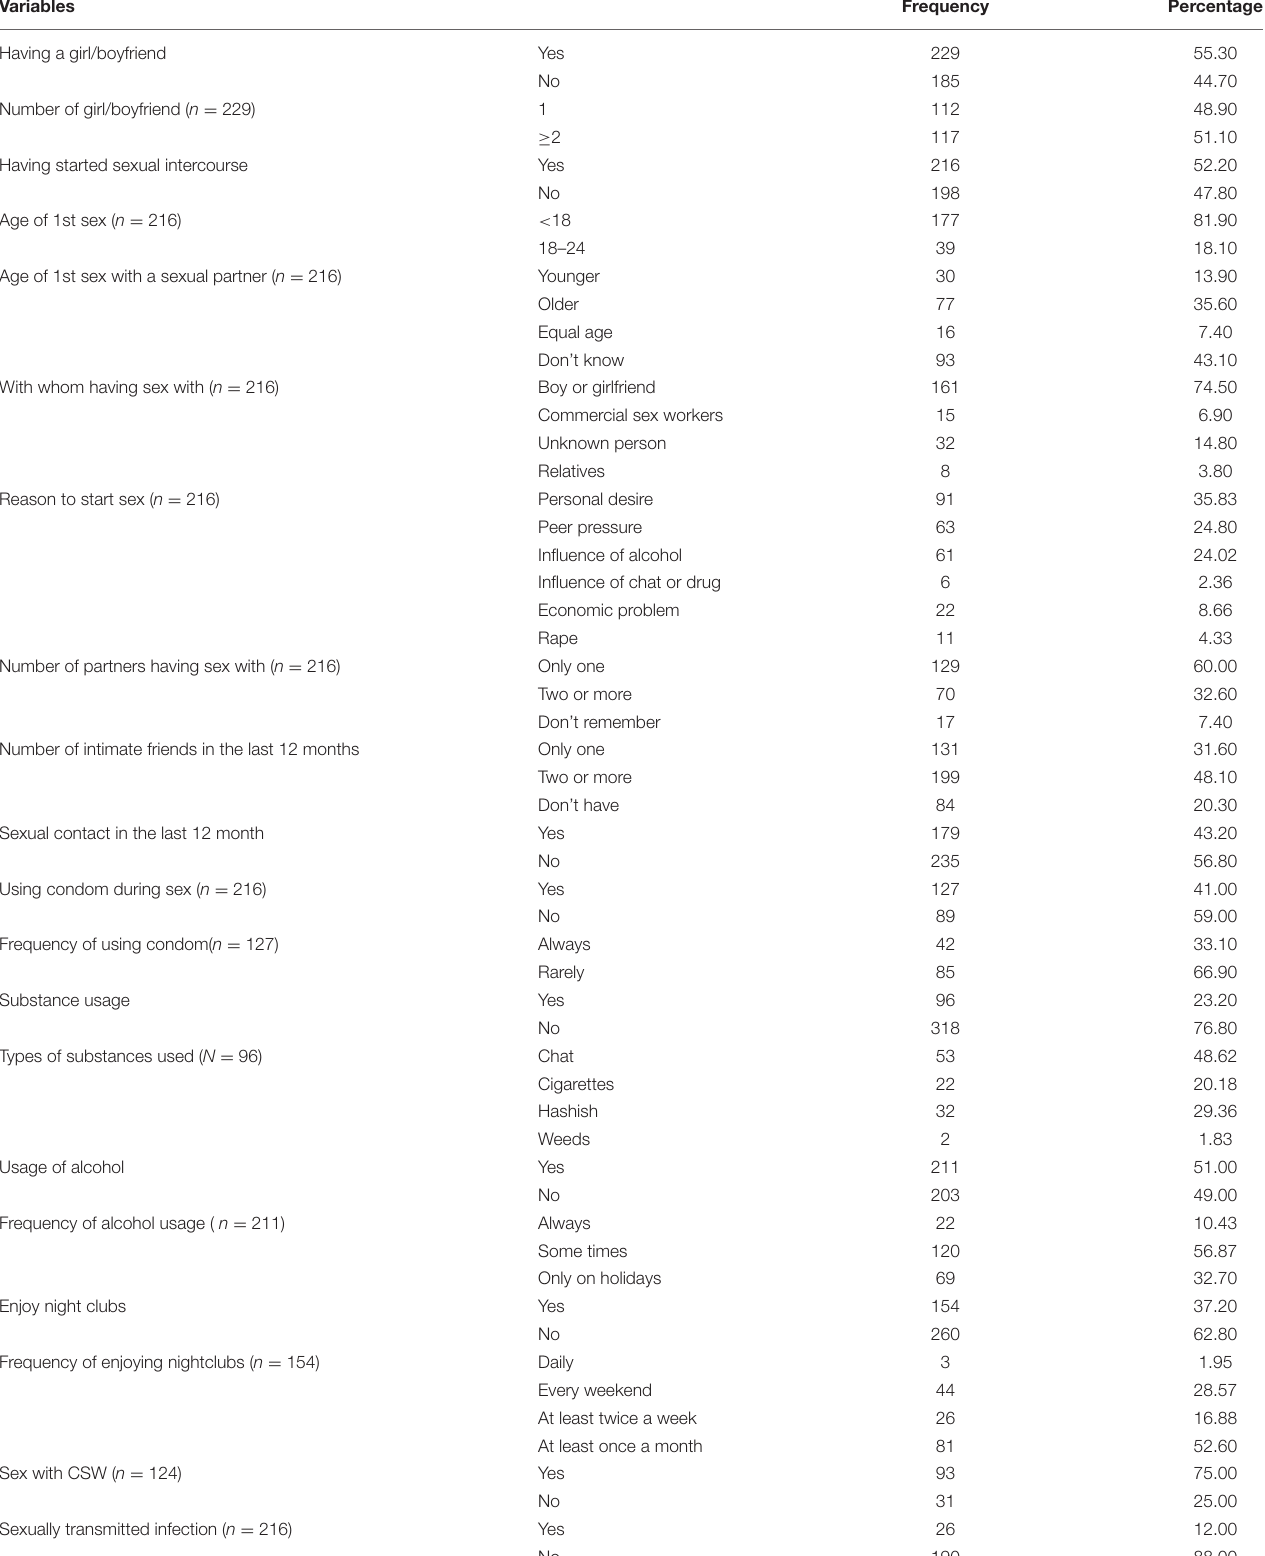
TABLE 2 | Sexual practice-related characteristics of study participants in Gondar city, Northwest Ethiopia, 2019 ( n = 414). Variables